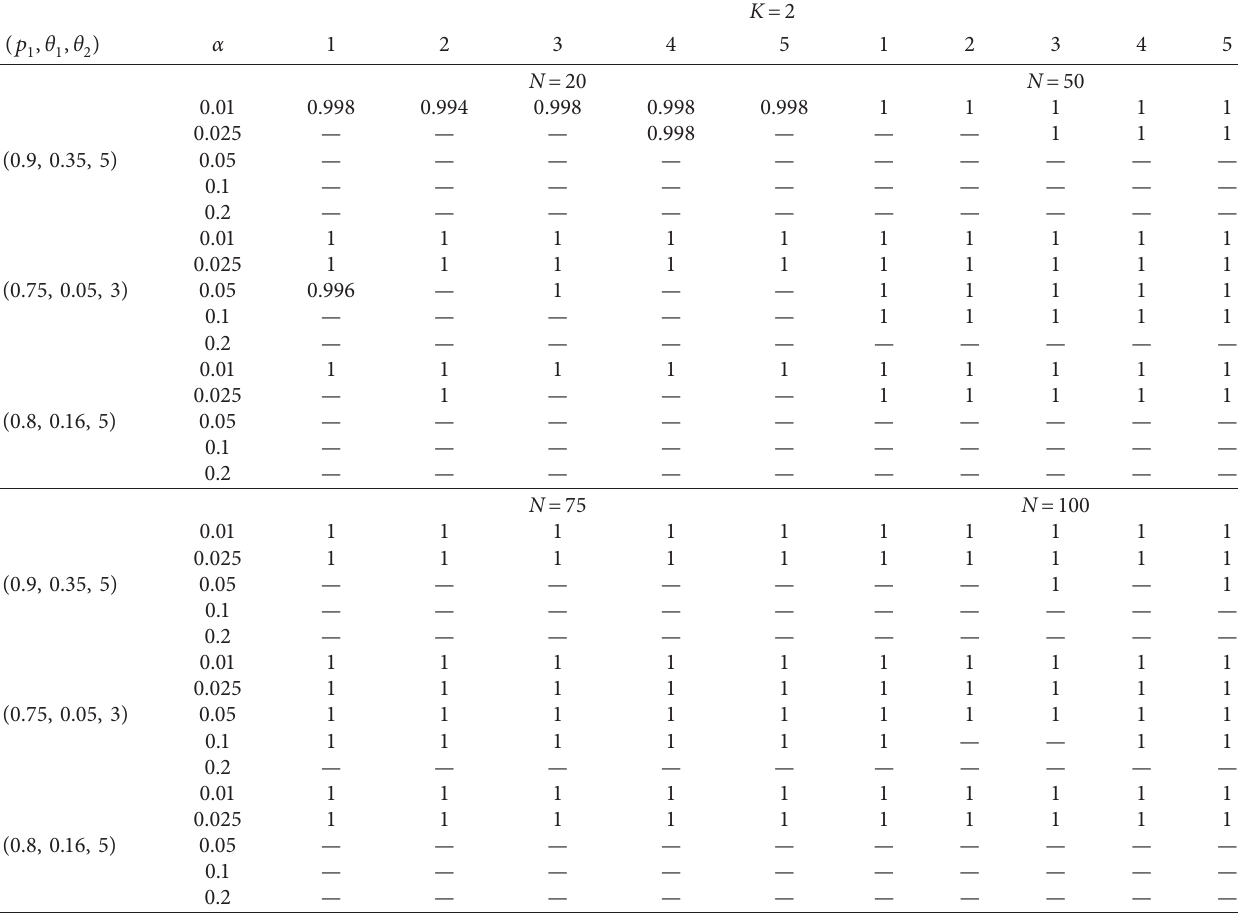
Table 4: Power results for estimated number of finite exponential components at k � 2.